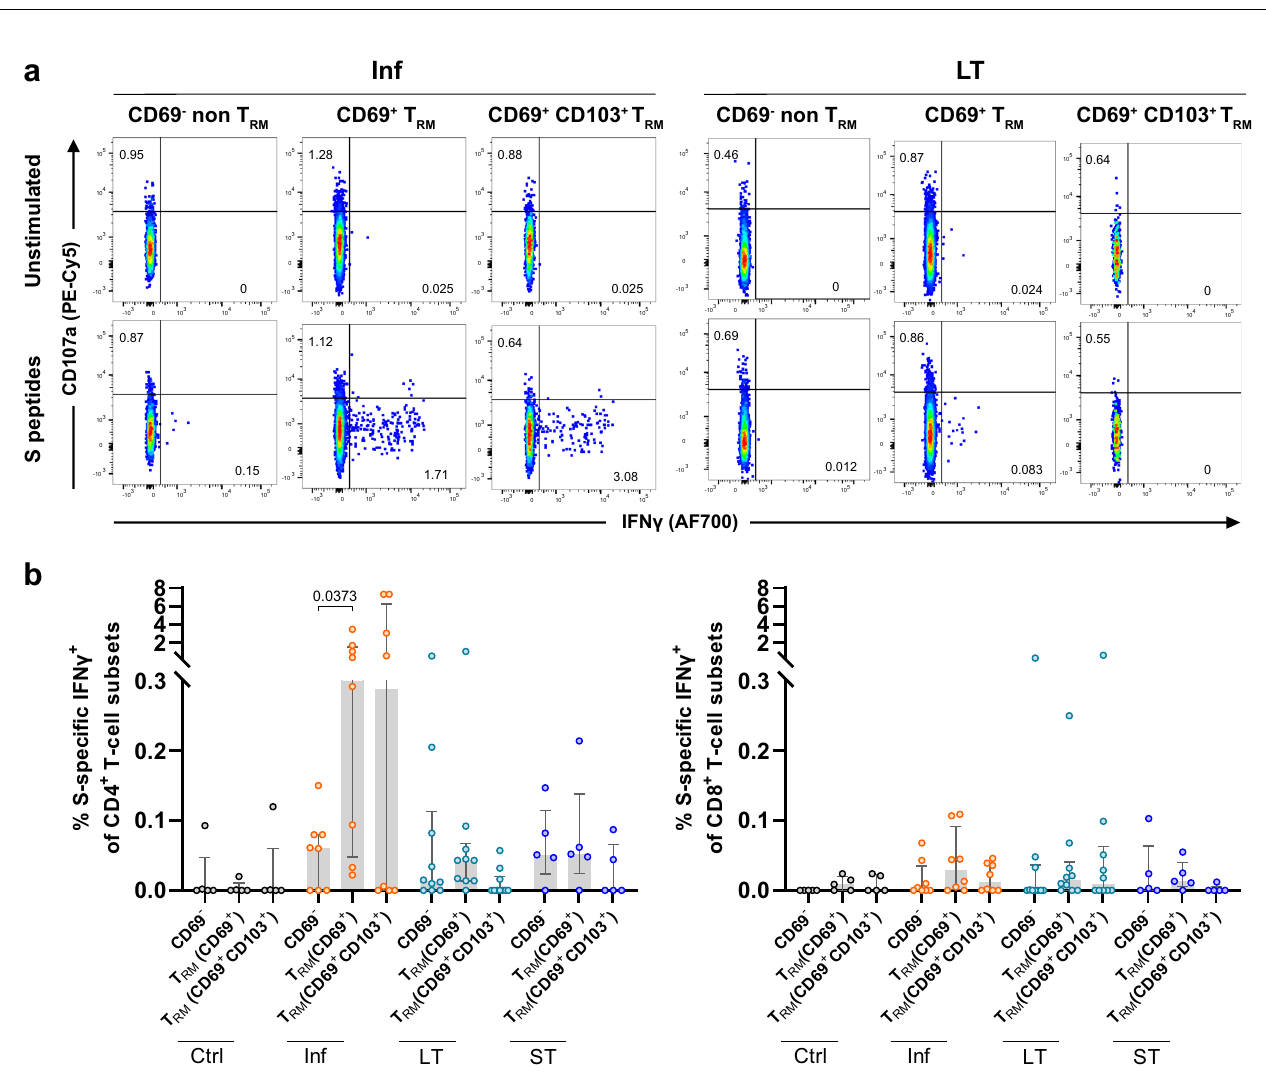
Fig. 2 | SARS-CoV-2-speci fi c lung T cell responses from convalescent and vac- cinated patients and comparison between tissue compartments. a Representative fl ow-cytometryplotsshowingCD4 + TcellsexpressingCD107aand IFN γ after exposure of single-cell suspensions of lung tissue to S-peptide pools or left unstimulated for each of the four groups included in this study (complete gating strategy is shown in Supplementary Fig. 2b). b Comparison of the net fre- quency (background subtracted) of IFN γ + cells within CD4 + (upper) and CD8 + (lower) T cell subsets after exposure of lung single-cell suspensions to any of the threeviralpeptidepools(membrane(M),nucleocapsid(N),andspike(S)peptides).